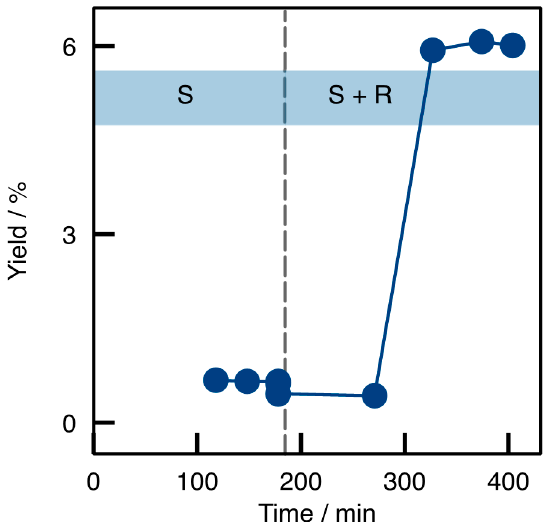
Figure 9. TA-A50-GA enantioselectivity. With S- BMBA enantiomer, the yield is low and corresponds to the non-enzymatic reaction. When the racemic BMBA is injected in the reactor at 180 min, the yield raises up to 6% after 2 h, which is the time required for the solution to reach the output.